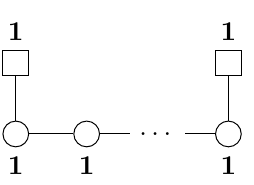
Figure 4 . A 3 d N = 4 quiver with n gauge nodes. Its Coulomb branch is isomorphic to the minimal nilpotent orbit of sl ( n + 1 ; C ) when the di(cid:11)erence of complex mass parameters